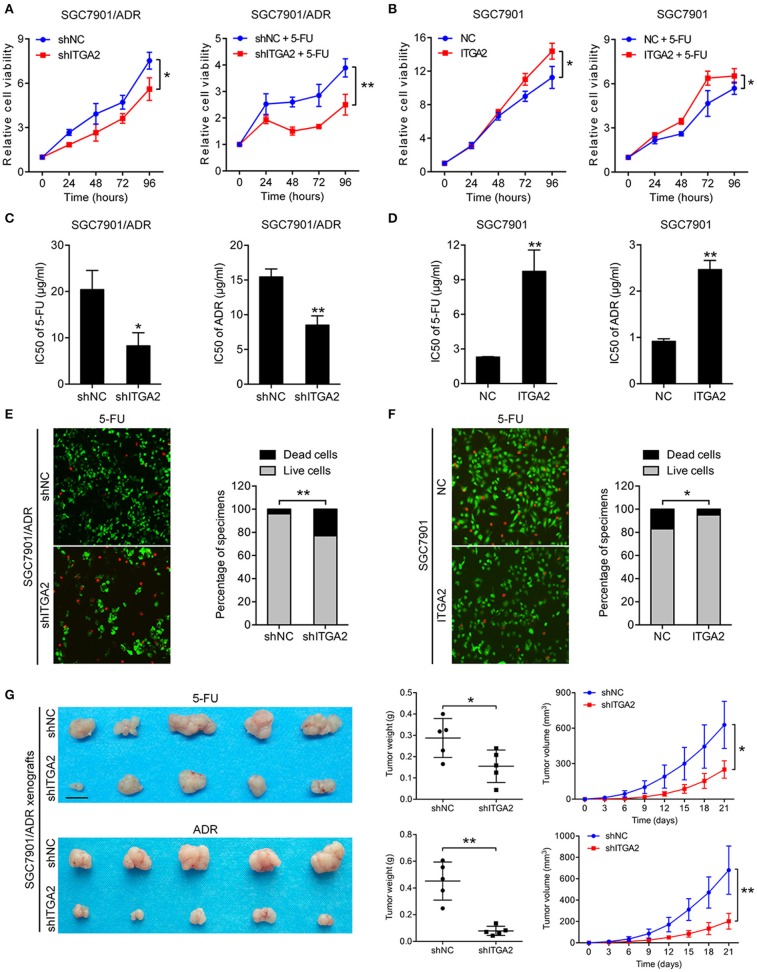
ITGA2 regulated chemoresistance in SGC7901 and SGC7901/ADR cells. (A) Cell proliferation analysis of SGC7901 cells when treated without or with 5-FU. (B) Cell proliferation analysis of SGC7901/ADR cells when treated without or with 5-FU. (C,D) IC50 of ADR and 5-FU when ITGA2 was overexpressed in SGC7901 cells and inhibited in SGC7901/ADR cells. (E,F) LIVE/DEAD viability analysis in response to 5-FU when overexpressed ITGA2 in SGC7901 cells and inhibited ITGA2 expression in SGC7901/ADR cells. (G) SGC7901/ADR cells with shITGA2 or vector control were injected into nude mice. Photos of xenograft tumors are shown on the right. Tumor weight and tumor growth curves are shown on the left. Data represent mean ± SD, from three replicates. *P < 0.05, **P < 0.01.